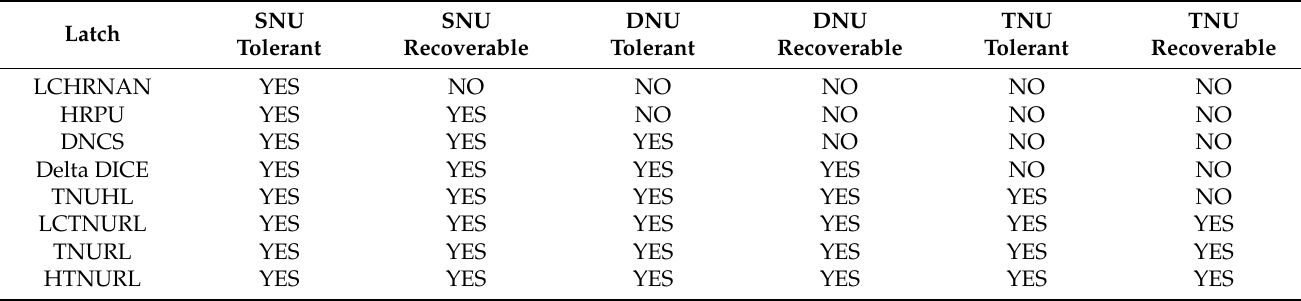
Table 1. Robustness comparisons among the typical radiation-hardened latches and HTNURL latch.